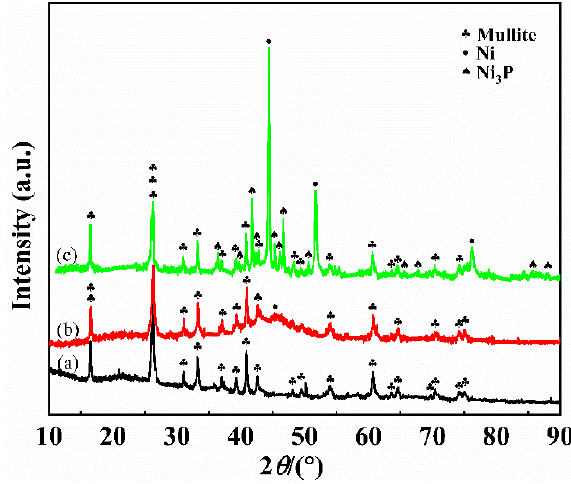
Figure 5. XRD patterns of the powders before and after the electroless plating: ( a ) raw mullite powders, ( b ) Ni–P/mullite composite powders, and ( c ) heat treatment at 850 °C for 60 min.